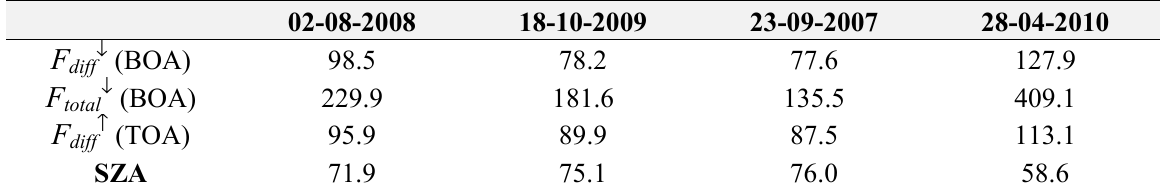
Table 1. Instantaneous broadband upwelling diffuse ( F ↓ ) fluxes calculated for four selected days using the AERONET-retrieved downwelling total ( F aerosol optical properties as part of the AERONET operational product for given solar zenith angles (SZA). Unit of these fluxes is W·m − 2 . Note that for the upwelling radiation, the diffuse flux is equal to the total flux.